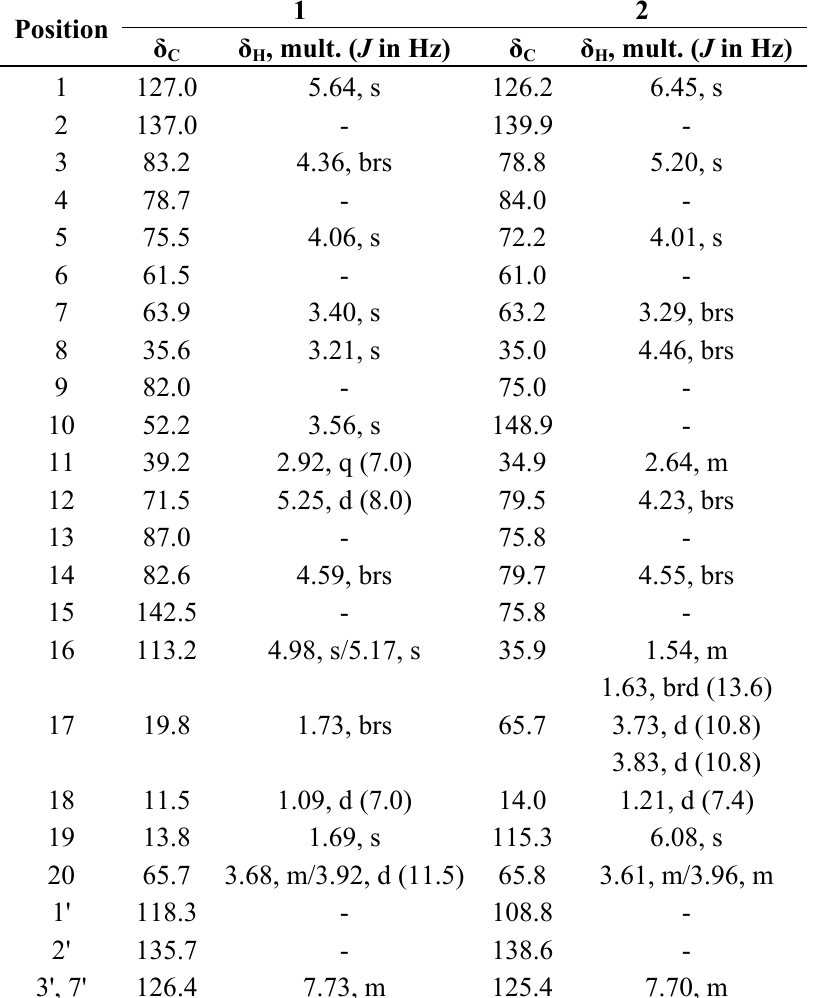
Table 1. NMR spectroscopic data (150 and 600 MHz, CDCl